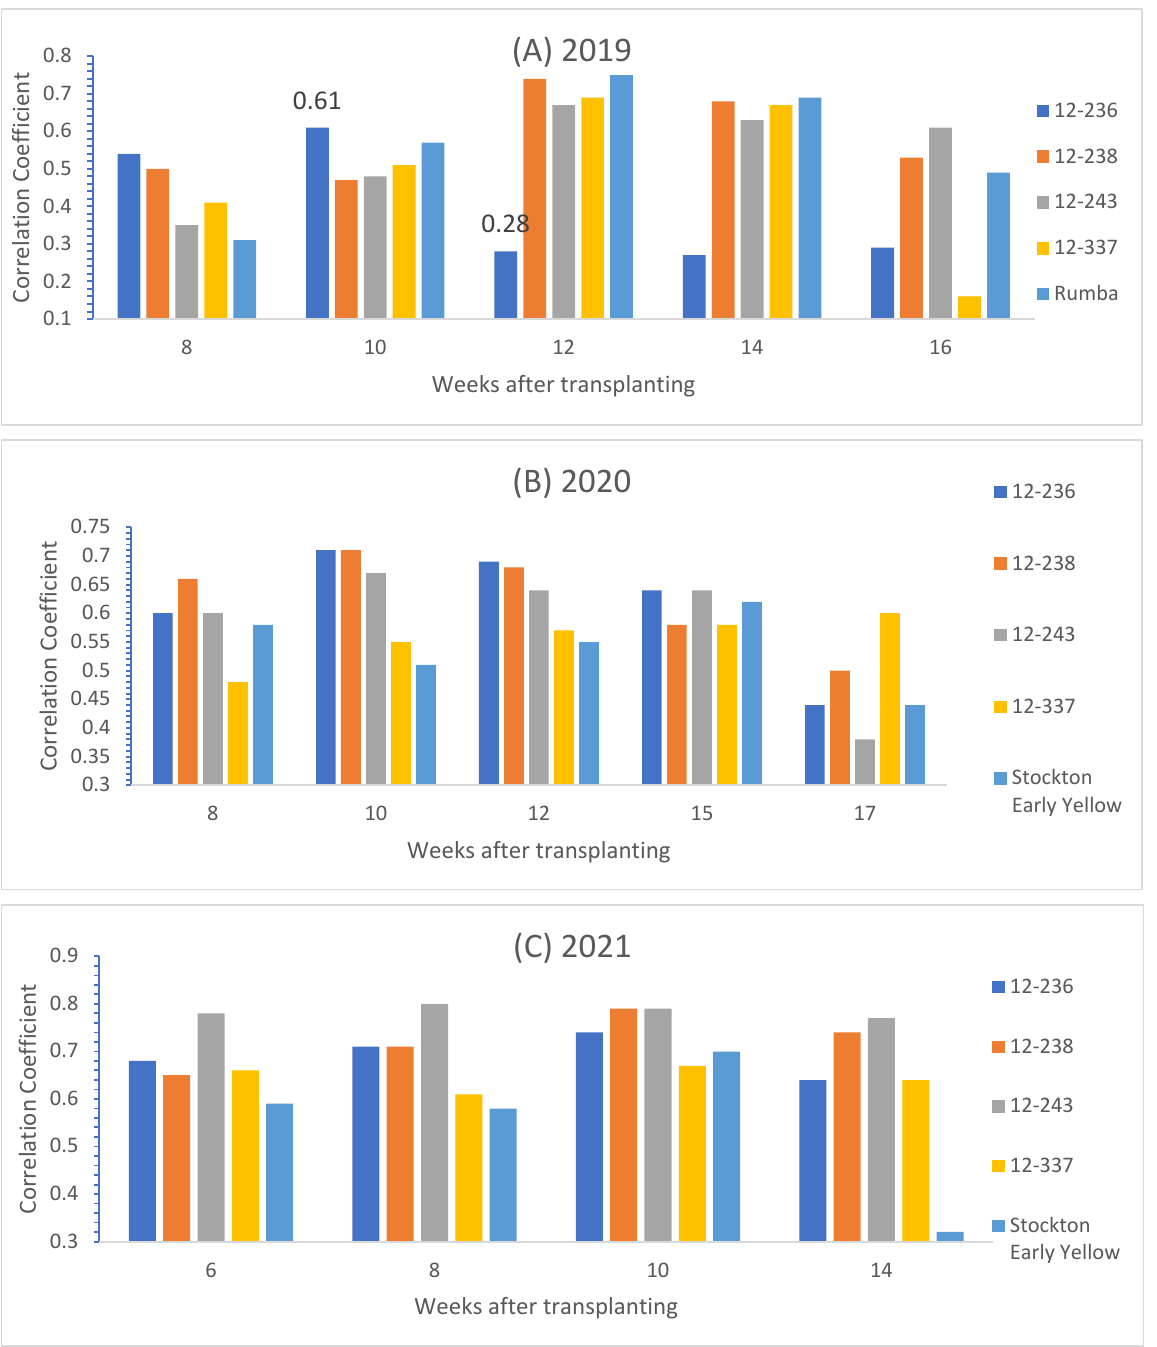
Figure 5. Correlations between bulb weight and leaf number through the growing season and for entries on per plant basis in ( A ) 2019, ( B ) 2020 and ( C ) 2021, at p < 0.001 significance level.